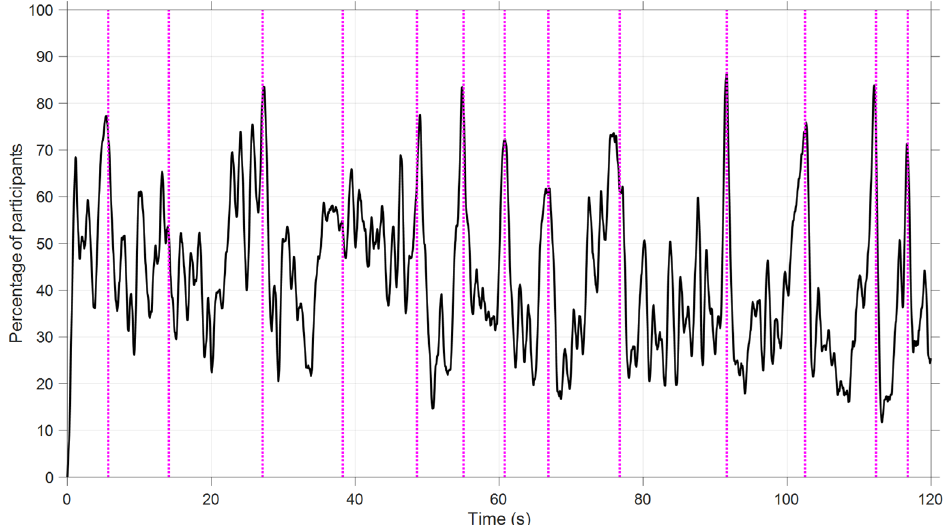
Figure 9. Percentage of participants with their eyes on the dashboard (Video 2, Speed Task). The dotted vertical lines represent the moments of 100 km/h threshold crossings.